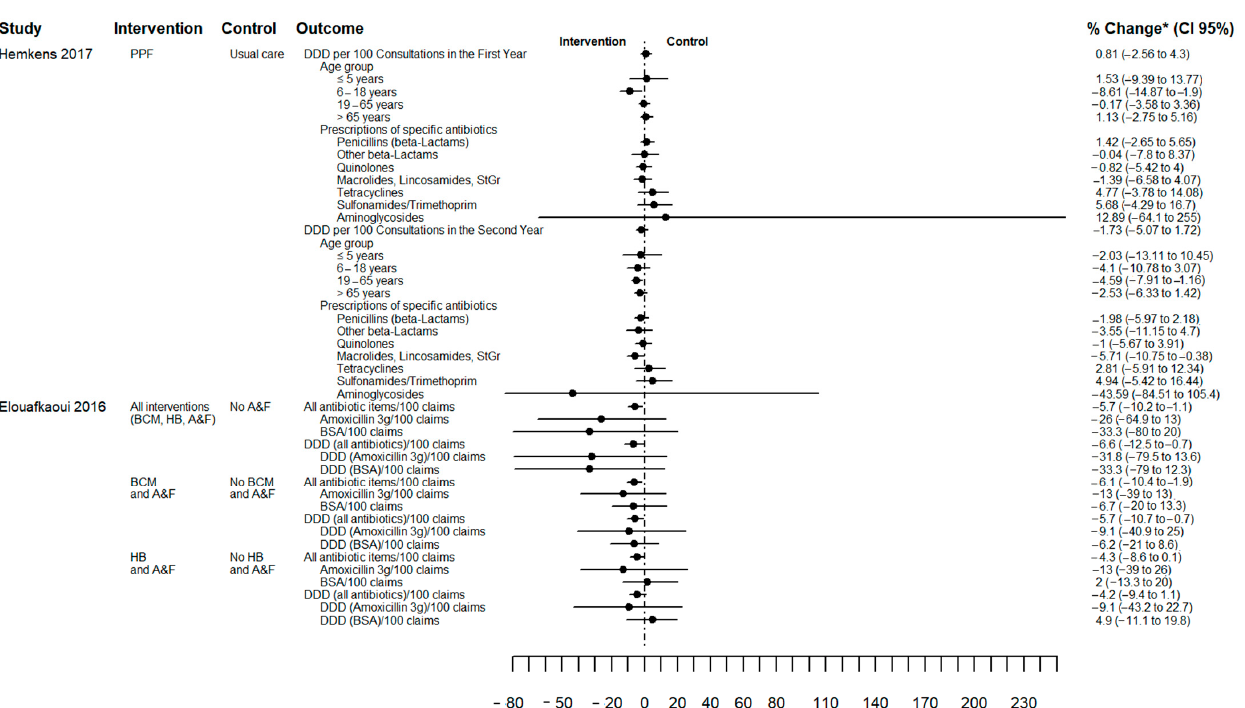
Figure 3. Forest plot of antibiotic prescribing change outcome in percentage of change from baseline (between-group difference). Source: elaborated by the authors with information reported of studies included. PPF: Personalised prescription feedback; BCM: written behaviour change message; HB: health board; A&F: audit and feedback; BSA: Broad spectrum antibiotics (clindamycin, co-amoxiclav, clarithromycin, cefalexin, and cefradine); DDD: defined daily doses; CI: confidence interval. * Hemkens (2017) reported change from Baseline (between-group difference) [28] and Elouafkaoui (2016) reported change from baseline with all percentages standardised using control group baseline mean prescribing rate [25] (see Table S3).